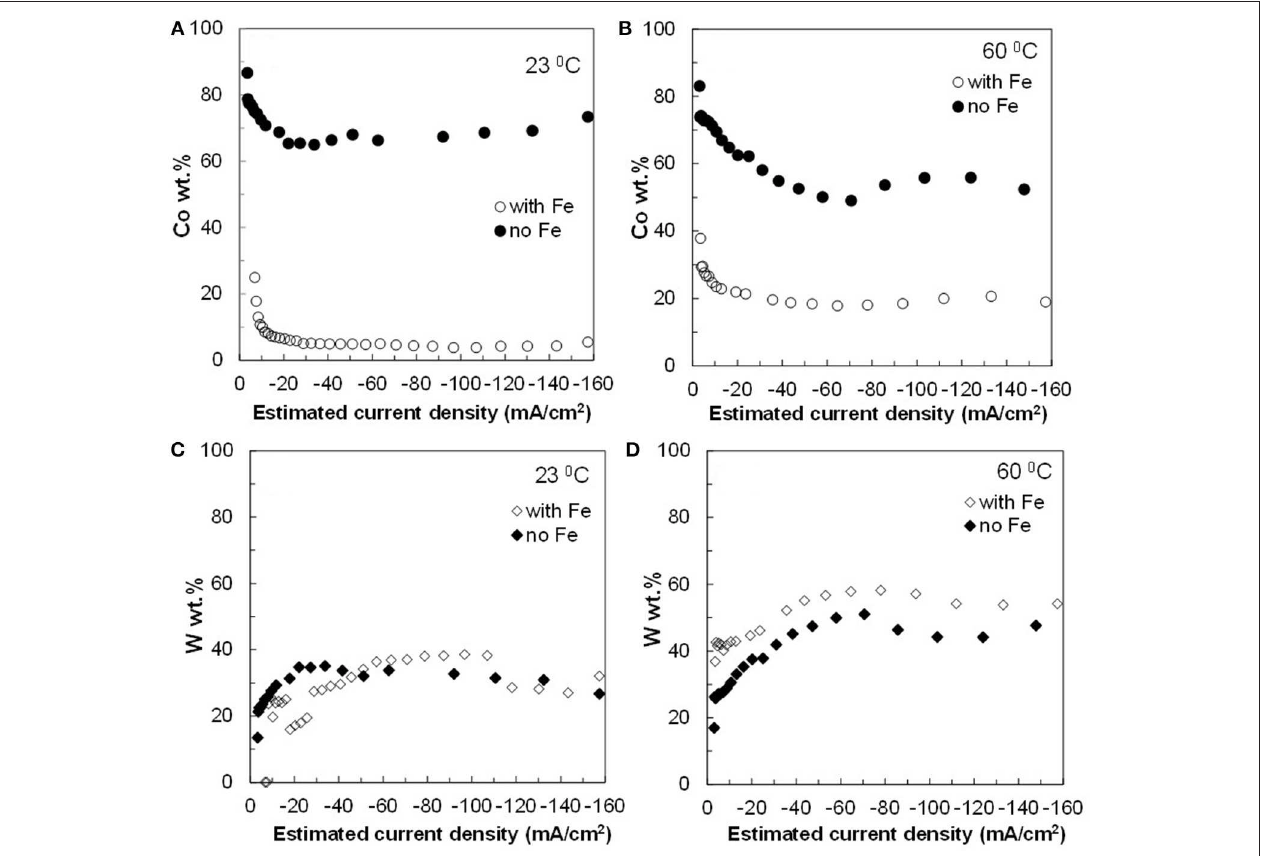
FIGURE 2 | Concentration of (A,B) Co and (C,D) W in Co–W and Fe–Co–W alloy films at two different temperatures 23 and 60 ◦ C, and at an electrode rotation rate of 300